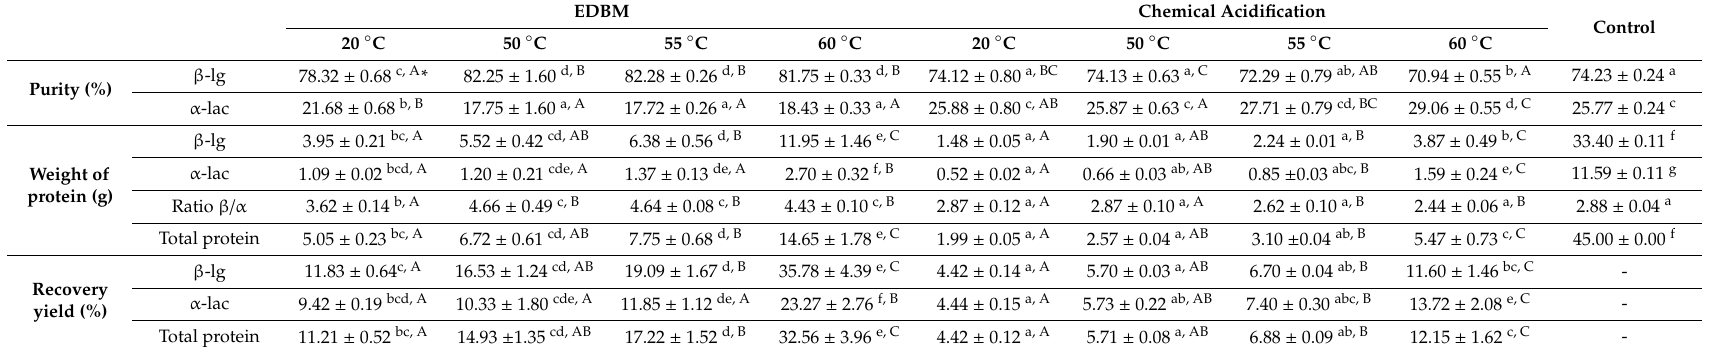
Table 3. Protein purity, weight of protein and recovery yield in the precipitate fractions recovered after acidification at pH